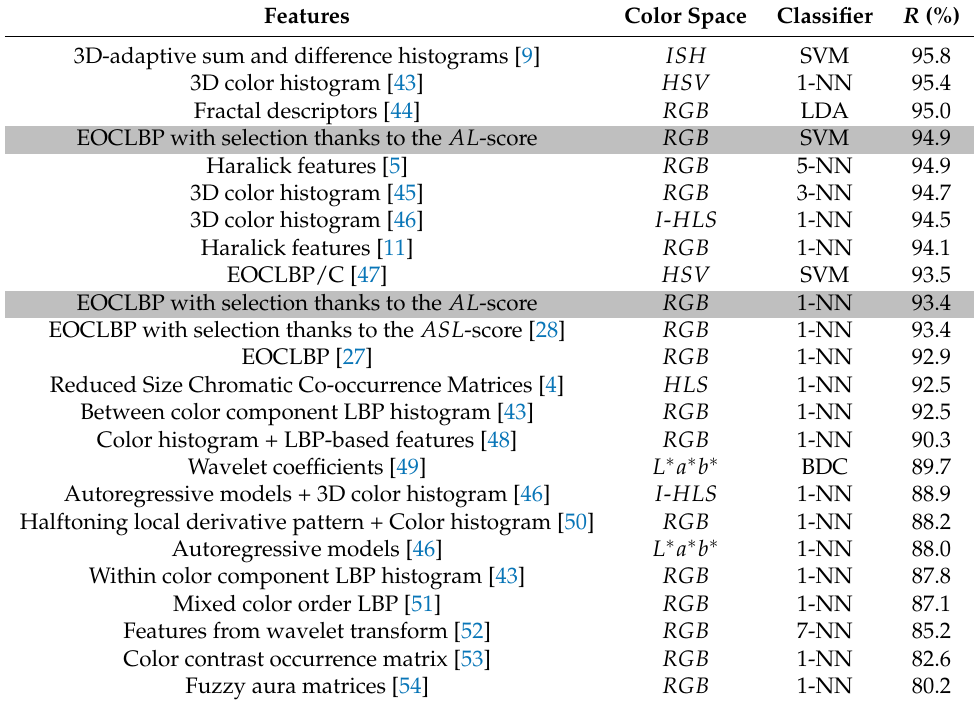
Table 6. Comparison between the classification accuracies reached with the Outex-TC-00013 set. Features